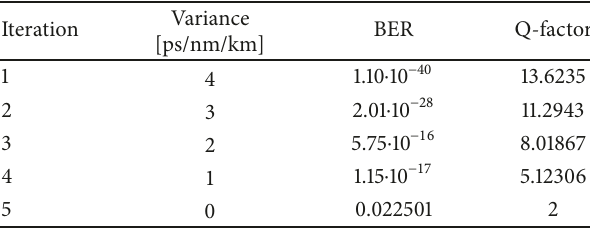
Table 2: Final BER results with simulation no. 2 193,075 THz.